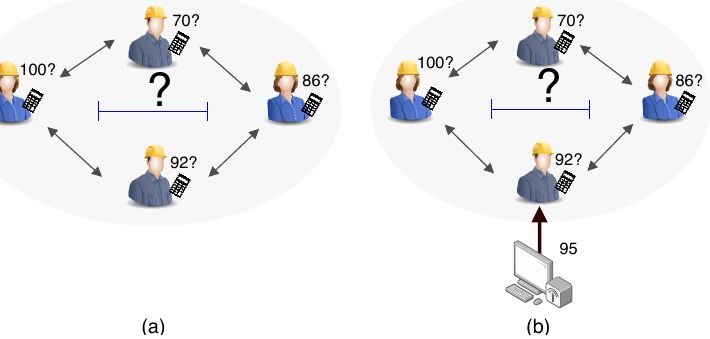
Figure 4. Group of engineers working to determine a specific quantity. ( a ) leaderless consensus problem; ( b ) leader-following consensus